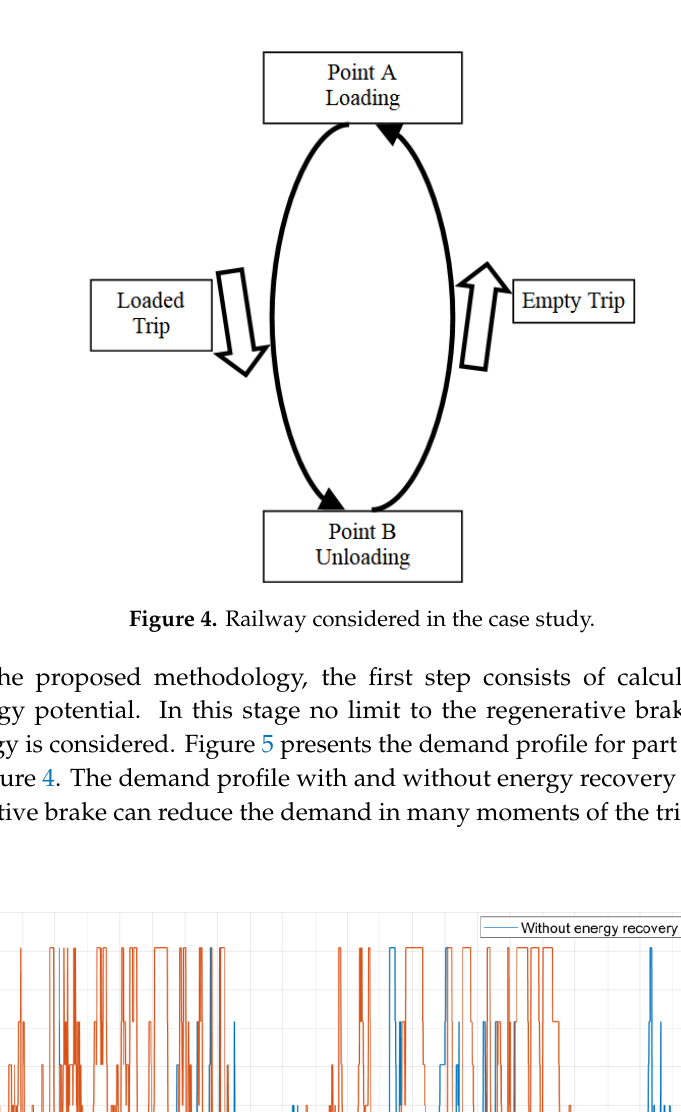
Figure 6. Recovered power (without limit to the storage size).